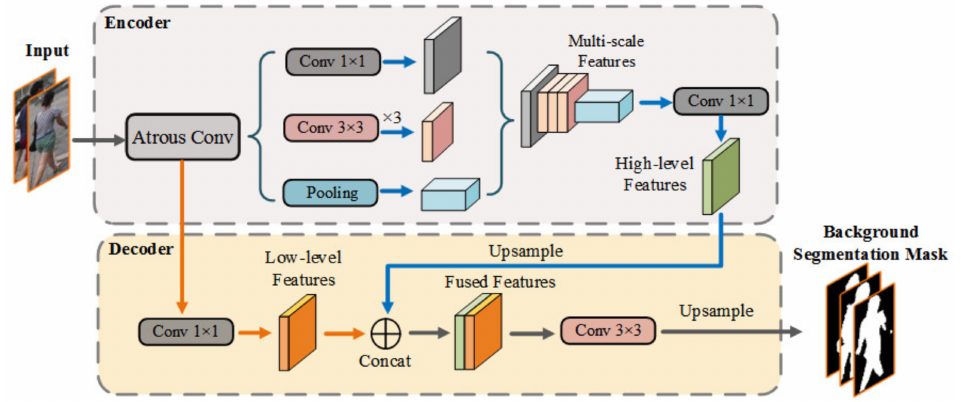
Figure 4. The process of background segmentation with